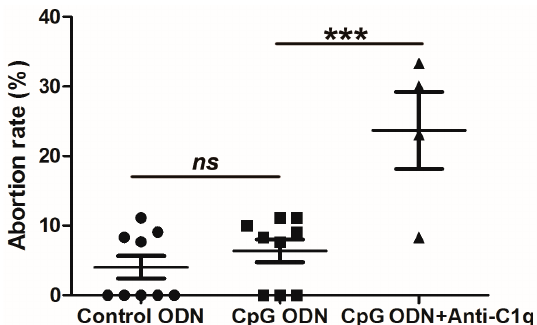
Figure 6. Effects of C1q on the pregnancy outcomes in CpG ODN-treated WT mice. The abortion rates of CpG ODN-treated WT mice were increased significantly when the function of C1q was inhibited by the neutralizing antibody. The abortion rates of pregnant mice were calculated. Data represent mean of the biological replicates ± SEM ( n = 9 in control ODN-treated group, n = 9 in CpG ODN-treated group, and n = 4 in CpG ODN plus Anti-C1q treated group), One-way ANOVA followed by Tukey’s test; ns , not significant; *** p < 0.001.